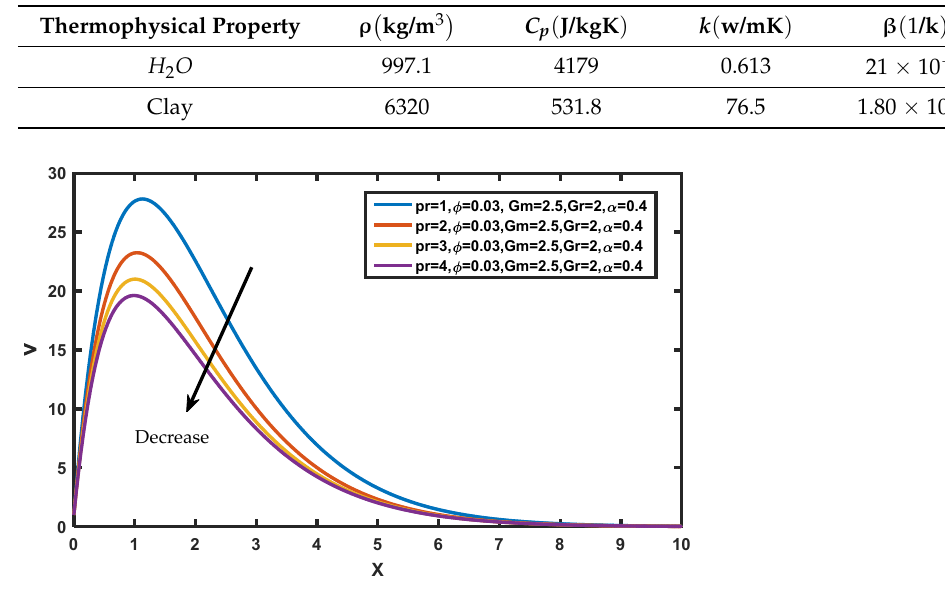
Figure 2. Variation of Pr in v .